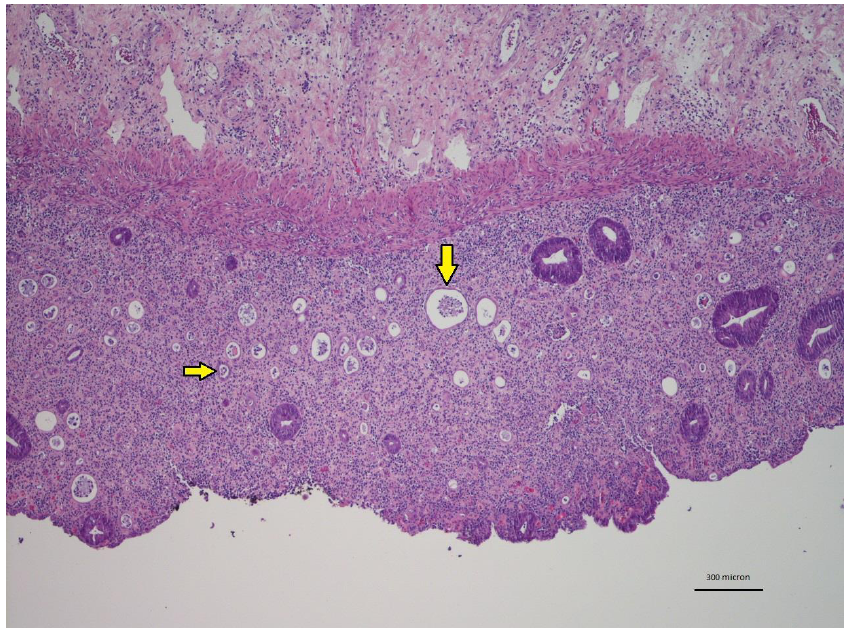
Figure 1. Low power view of radiation-damaged non-neoplastic mucosa in PSRT sample: The lamina propria looks expanded by inflammatory cells and crypts (yellow arrows) are decreased (Hematoxylin and Eosin (HE) 40 times magnified). Scale Bar: 300 microns. Cancers 2020 , 12 , x